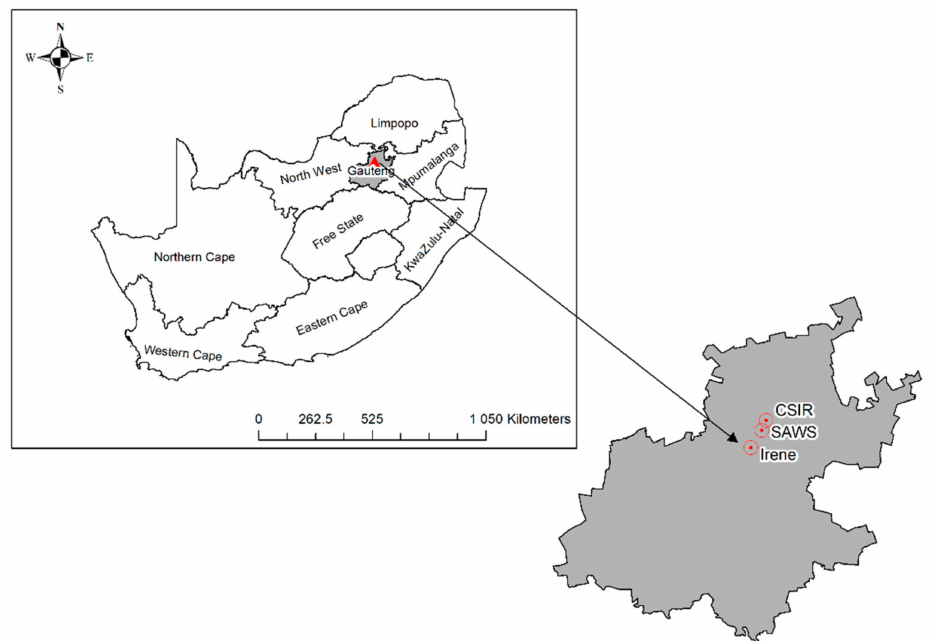
Figure 1. Map showing the location of Pretoria in South Africa and the three stations where data were collected from the Council for Scientific and Industrial Research (CSIR) head office, South African Weather Service (SAWS) Bolepi House and SAWS Irene weather stations,